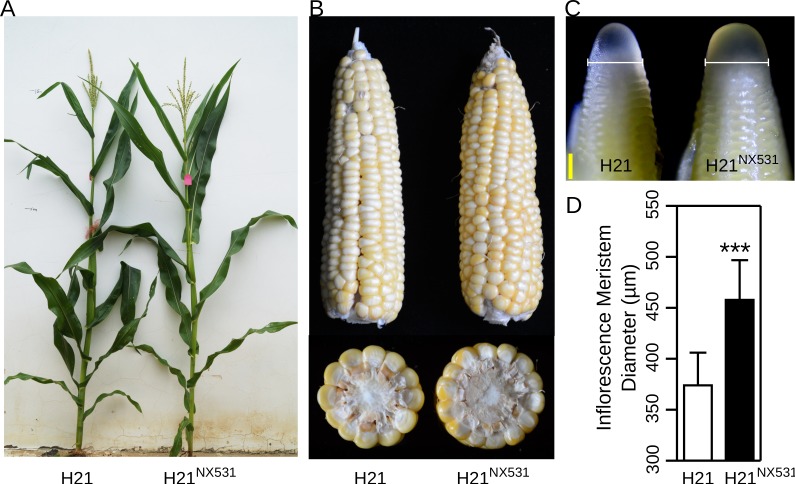
The plant and inflorescence performance of H21 and H21NX531.A) The plant performance of H21 (right) and H21NX531 (left). B) The mature ears of H21 and H21NX531. C) Diameter of inflorescence meristems in H21 and H21NX531, micrograph of apical 2-mm immature ears of H21 (left) and H21NX531 (right), white bracketed lines represent inflorescence meristem diameters. Bar = 200 μm. D) The statistical analysis of inflorescence meristem diameters between H21 and H21NX531. *** P < 0.001. N: 8/7 for H21 and H21NX531.